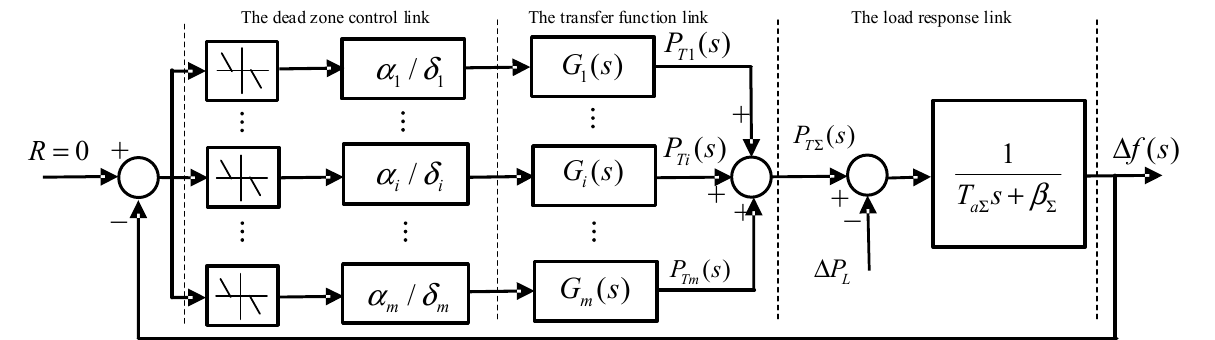
Figure 4. The mathematical model of primary frequency regulation with m generators running in parallel.